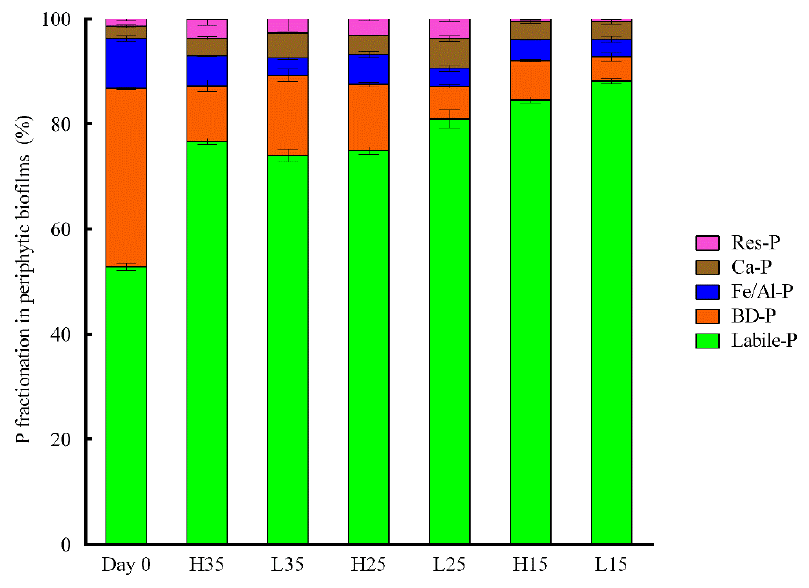
Figure 6. Phosphorus fractionation in the periphyton on day 0 and day 12 in different treatments.